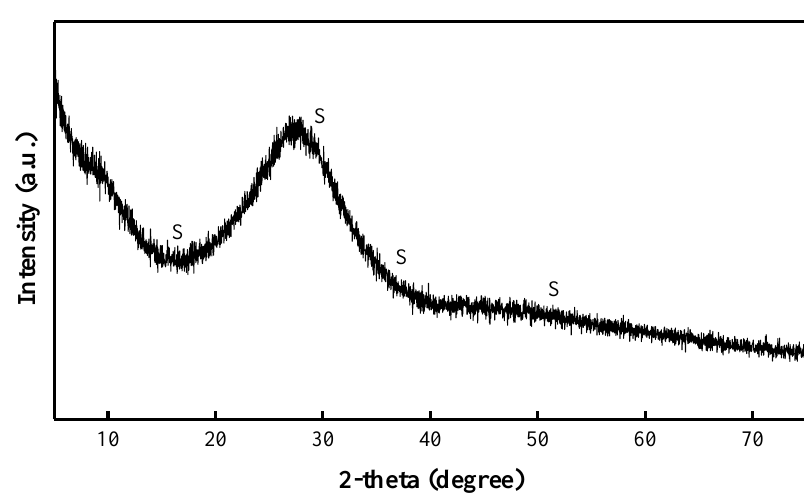
Figure 3. XRD pattern of Na 2 SiO 3 (S: Na 2 SiO 3 ).